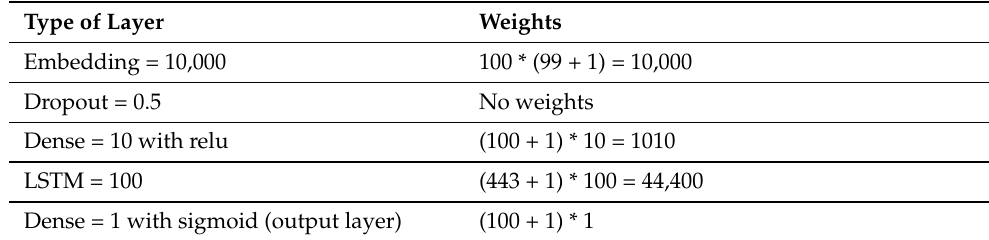
Table 6. Layered-wise details for LSTM.